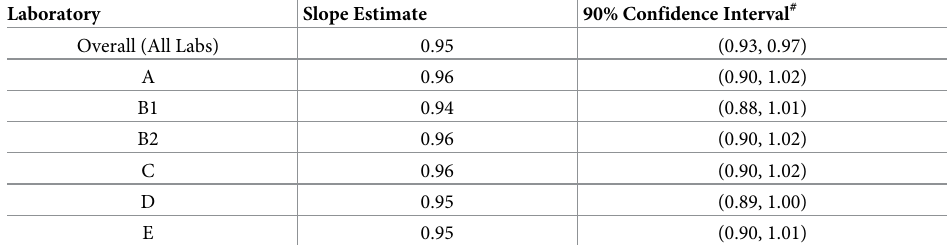
Table 8. Estimated slope and lower and upper 90% confidence interval bounds by laboratory from random coeffi- cients regression model fit to all